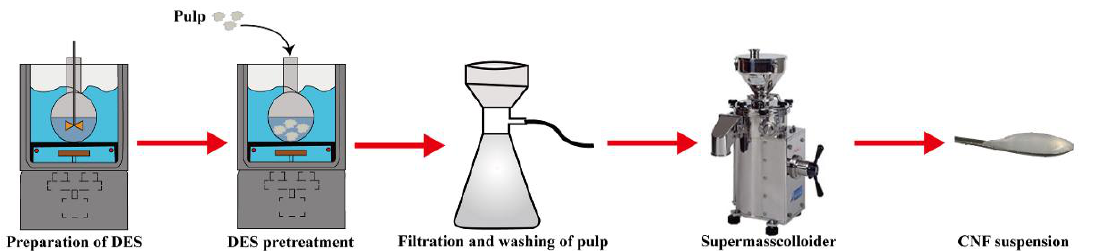
Figure 1. The preparation scheme of DES-untreated and DES-treated CNF.